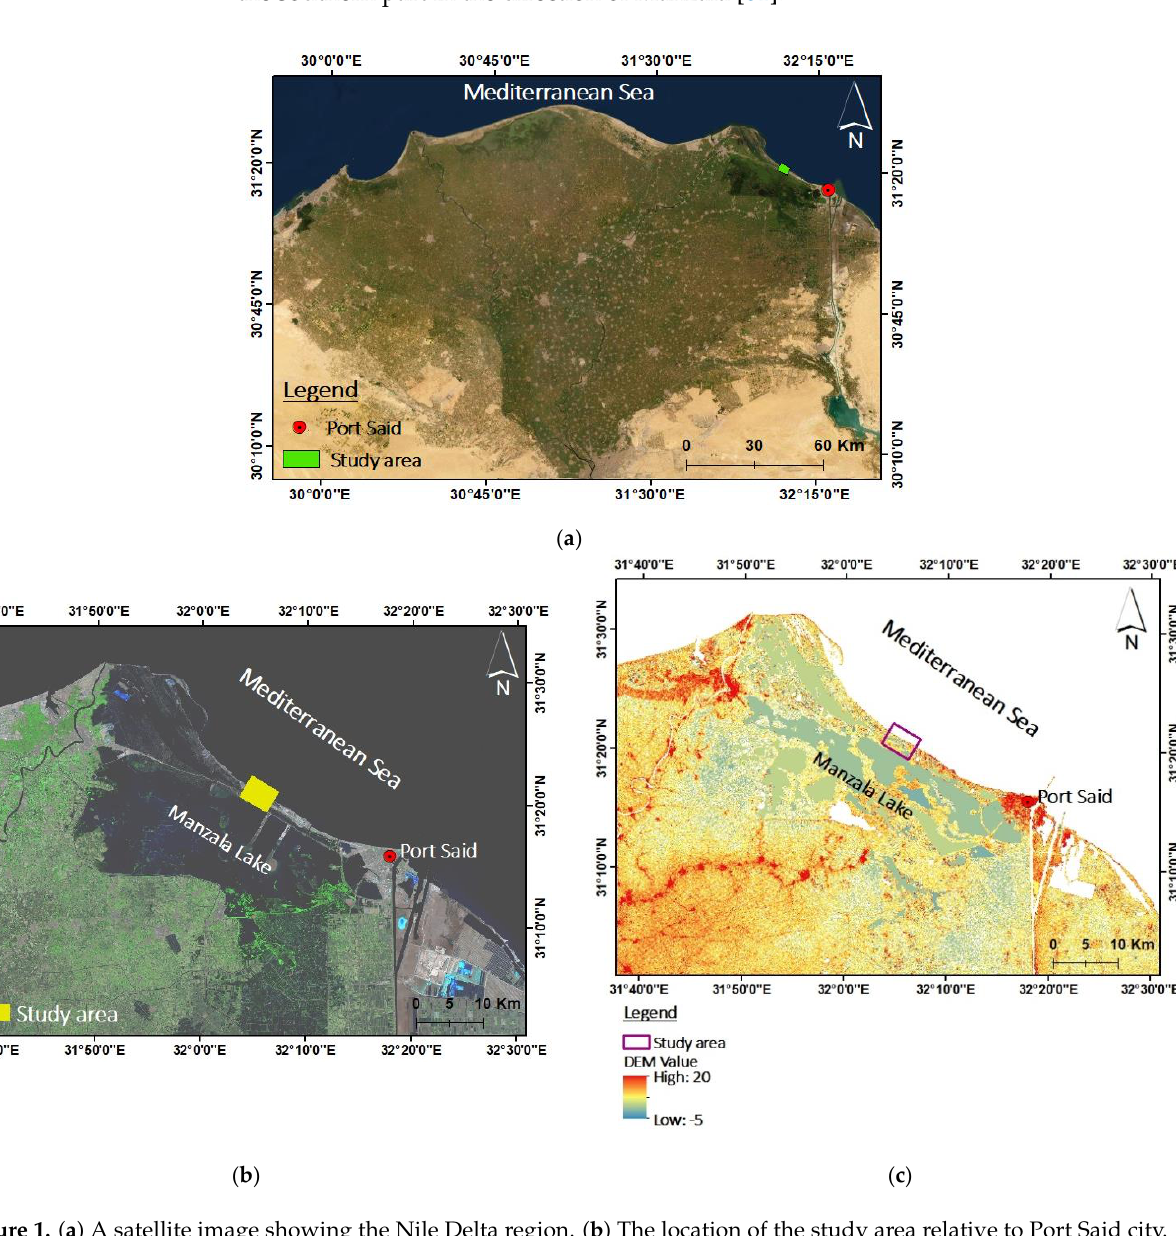
Figure 1. ( a ) A satellite image showing the Nile Delta region. ( b ) The location of the study area relative to Port Said city. ( c ) Digital elevation model for the study area and surrounding.